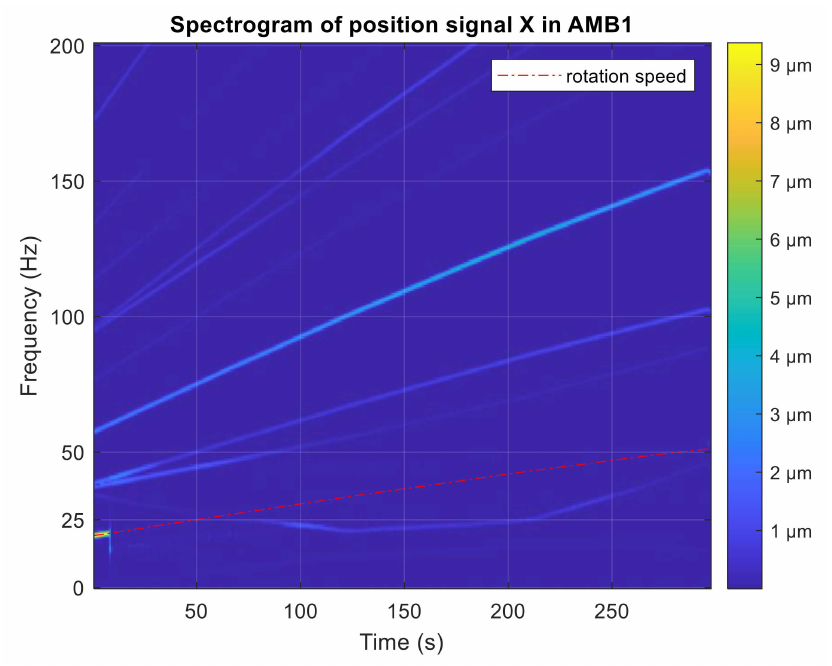
Figure 14. STFT spectrogram of position signal during run-up with AVC. The first orbit generation experiment was performed with constant rotor spin speed 3000 rpm without AVC. The generalized notch filter was used to excite the circular whirl motion of the rotor. The radius of the circular orbit was 50 µ m and the whirling frequency of the rotor was 25 Hz. Rotor vibrations were measured in the AMB housing by the integrated eddy-current sensors in axis x and y . Figure 15 shows rotor orbits measured in planes of radial magnetic bearings and related amplitude spectra of the measured position signals.